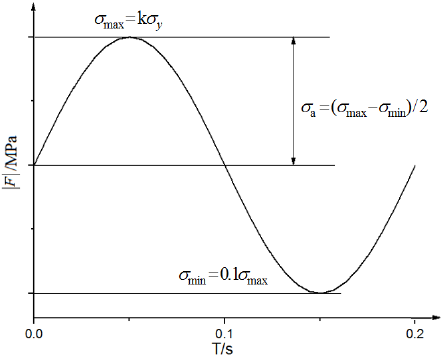
Figure 2. Load curve of one fatigue cycle.